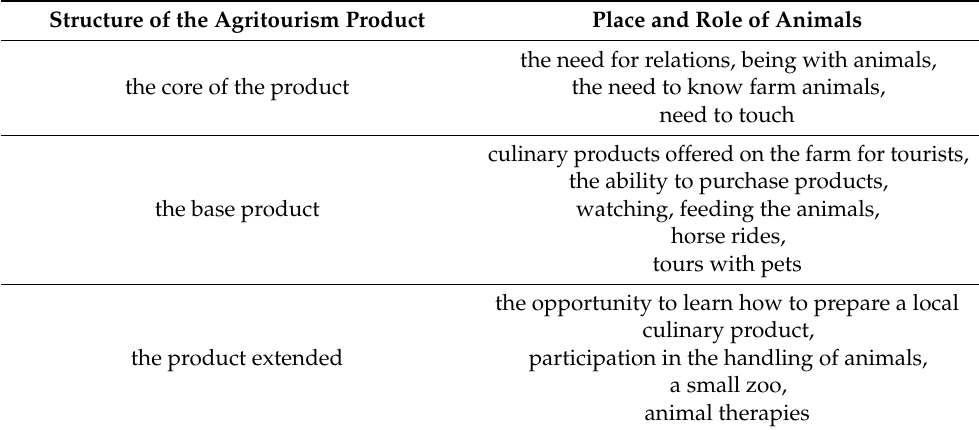
Table 2. Farm animals as an element of an agritourism product.